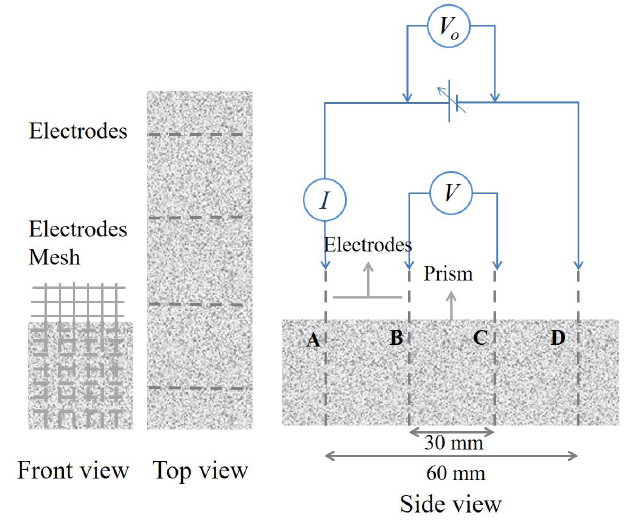
Figure 4. Illustration of the direct-current four- pole